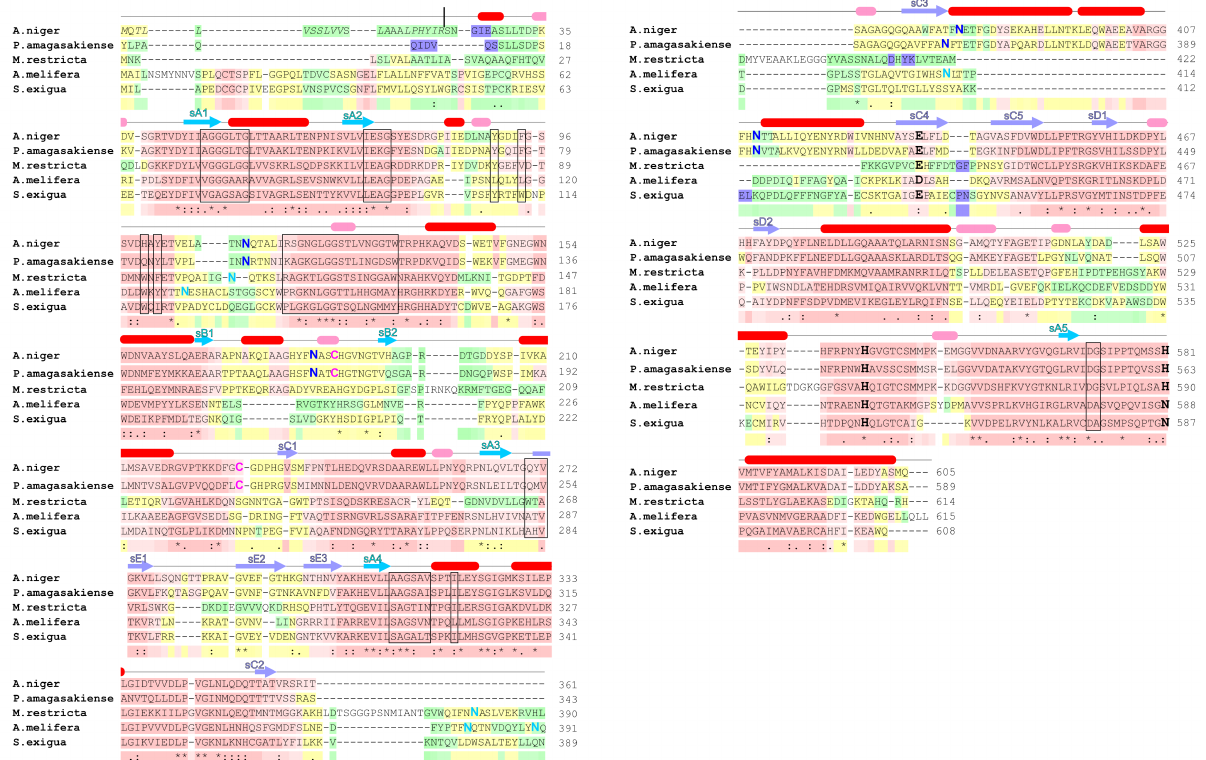
Figure 6. Amino-acid sequence alignment of GOx from A. niger (UniProt ID P13006), P. amagasakiense (P81156), M. restricta (A0A3G2SBT7), A. melifera (Q9U8X6) and S. exigua (D9ZFI1) performed by T - COFFEE [93]. The overall amino-acid sequence identity is 36%. The alignment is over the full- length sequences found in the UniProt database, which includes likely N-terminal presequences. The secondary structure elements shown are based on those derived from the 1.9 Å wild-type A. niger GOx structure (PDB ID 1 CF 3). Red and pink cylinders represent α -helices and 3 10 helices, respectively; blue and purple arrows indicate parallel and anti-parallel β -sheets, respectively. Individual β -strands within each β -sheet (A–E) are numbered according to their position in the structure rather than the sequence (see Figure 2). The A. niger GOx presequence cleavage site (R22) is marked with a vertical line. The positions of the crucial catalytic residues His-516, His-559 and Glu-412 (corresponding respectively to residues 538, 581 and 434 in the full-length sequence) are shown in larger and bold-face type. Residues participating in FAD binding are in boxed. Cysteines forming a disulfide bond in the A. niger and P. amagasakiense structures are shown in larger, bold-face, pink type. The glycosylation sites observed in the A. niger and P. amagasakiense structures (Asn-89, 161, 355 and 388, corresponding respectively to residues 111, 183, 377 and 410 in the full-length sequence) are shown in larger, deep blue type. The positions of potentially glycosylated asparagines in the M. restricta , A. melifera and S. exigua GOx sequences are shown in larger, light blue